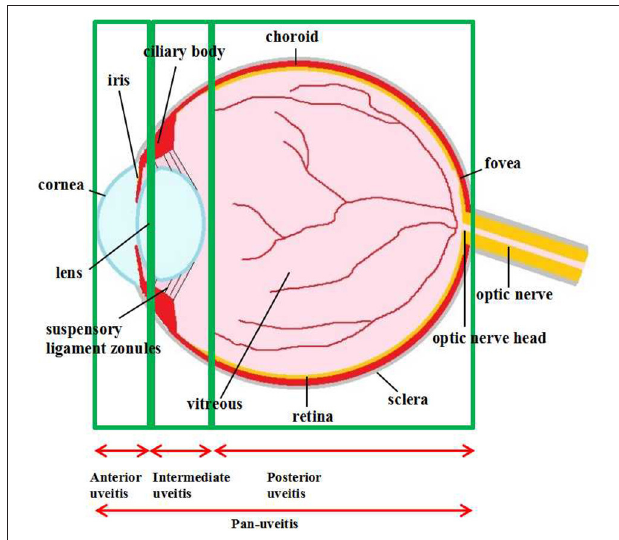
FIGURE 1 | Anatomical classification of uveitis. Uveitis is classified as anterior, intermediate, posterior uveitis, and panuveitis according to the anatomic location of the inflammatory